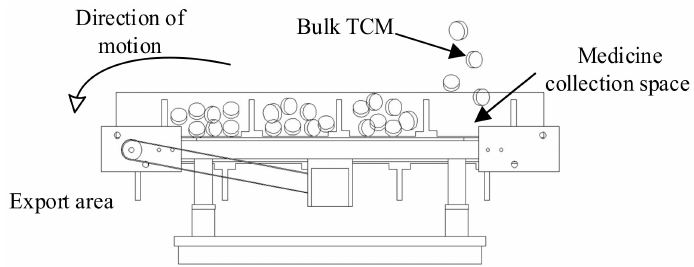
Figure 21. Solution corresponding to Preliminary